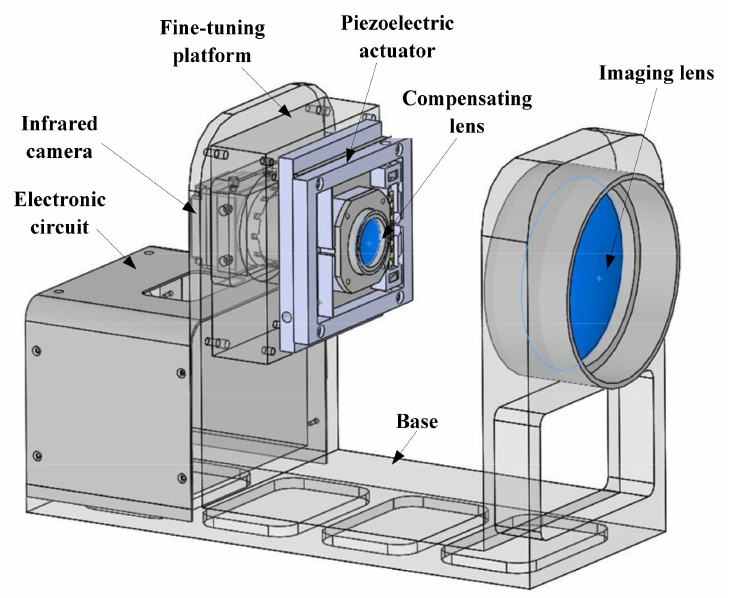
Figure 14. The overall structure of the infrared optical image stabilization system.